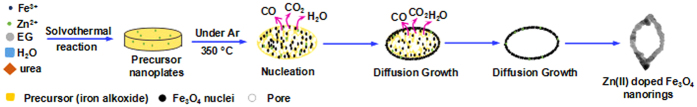
Schematic illustration of the formation of Zn(II)-doped magnetite nanorings.